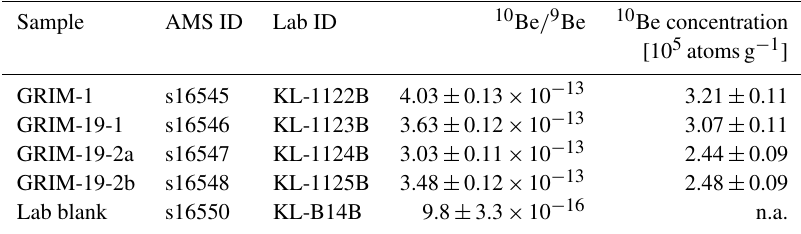
Table 3. 10 Be results for quartz samples from the Grimsel Pass, Switzerland. GRIM-19-2a and GRIM-19-2b are duplicate measurements of sample GRIM-19-2. The uncertainties denote the standard deviation (1SD). 10 Be concentrations are reported after the chemistry blank correction. Samples with 24.03 to 28.33g quartz were spiked with ca. 300µgBe using a commercial Beryllium ICP standard solution (Scharlau), with a concentration of 1000mgL − 1 traceable to NIST; n.a.: not